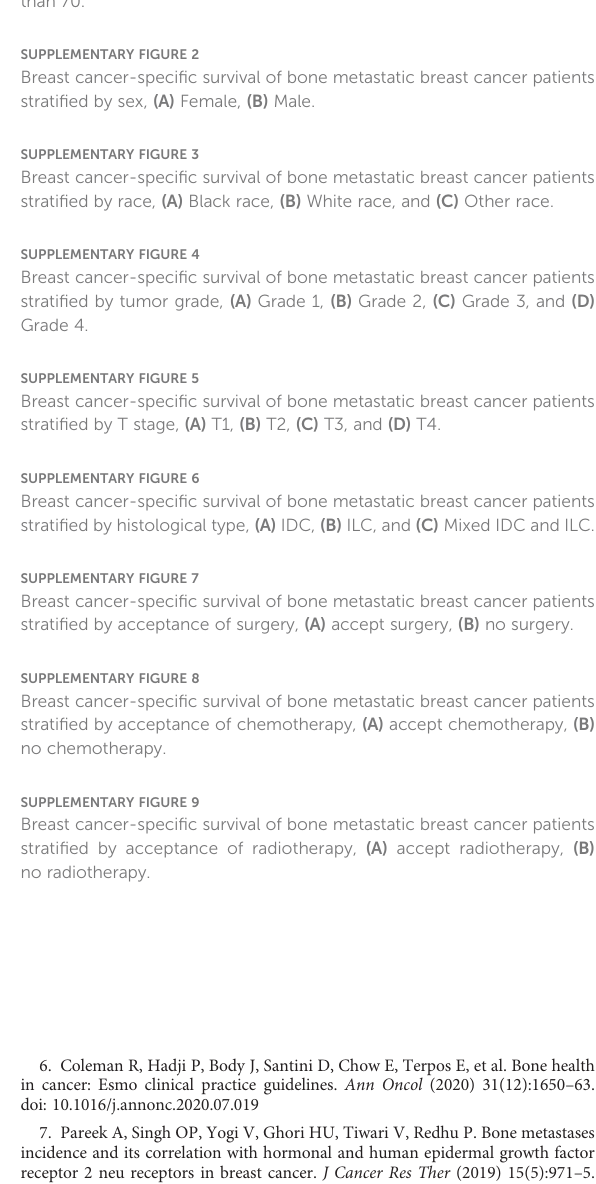
SUPPLEMENTARY FIGURE 1 Breast cancer-speci fi c survival of bone metastatic breast cancer patients strati fi edbyage, (A) youngerthan49, (B) between50and70,and (C) older than 70.